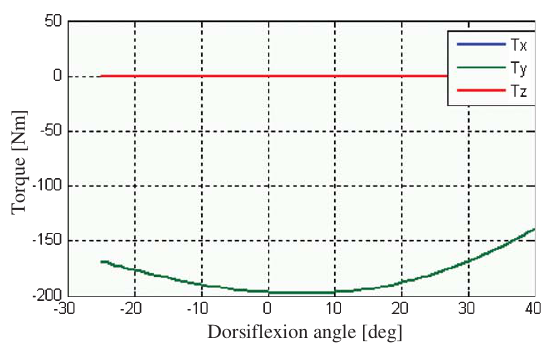
Fig. 11. Tx, Ty: lower curve, Tz: upper curve. Fig. 12. Tx,Tz,Ty: top (on the left), middle and bottom curve, resp.